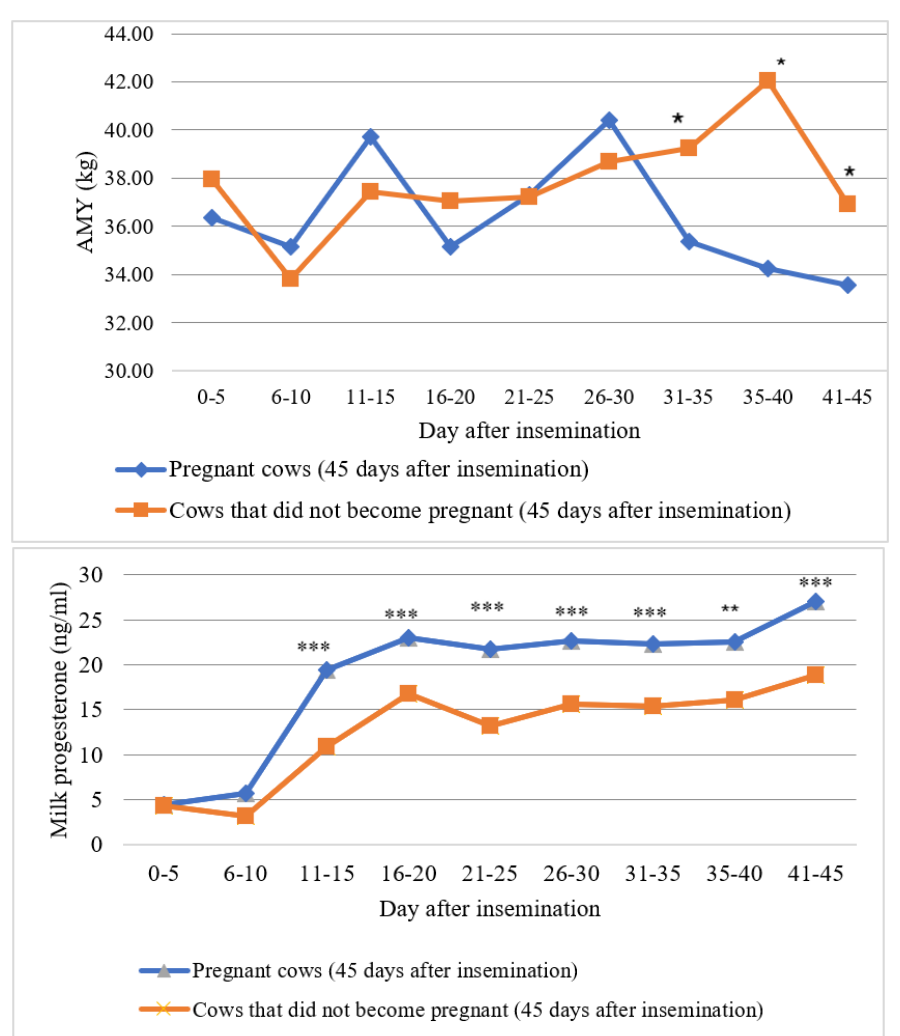
Figure 4. Changes in milk yield and progesterone in cows that became pregnant and did not become pregnant after insemination (* p < 0.05, ** p < 0.01, *** p < 0.001—average values between did-become-pregnant and did-not-become-pregnant cows are statistically significantly different).